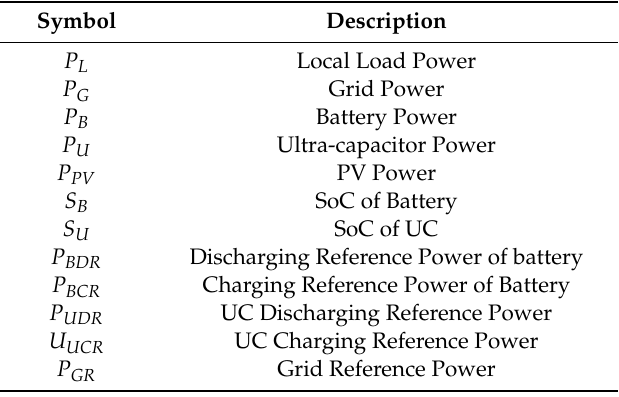
Table 1. Inputs / outputs of the proposed